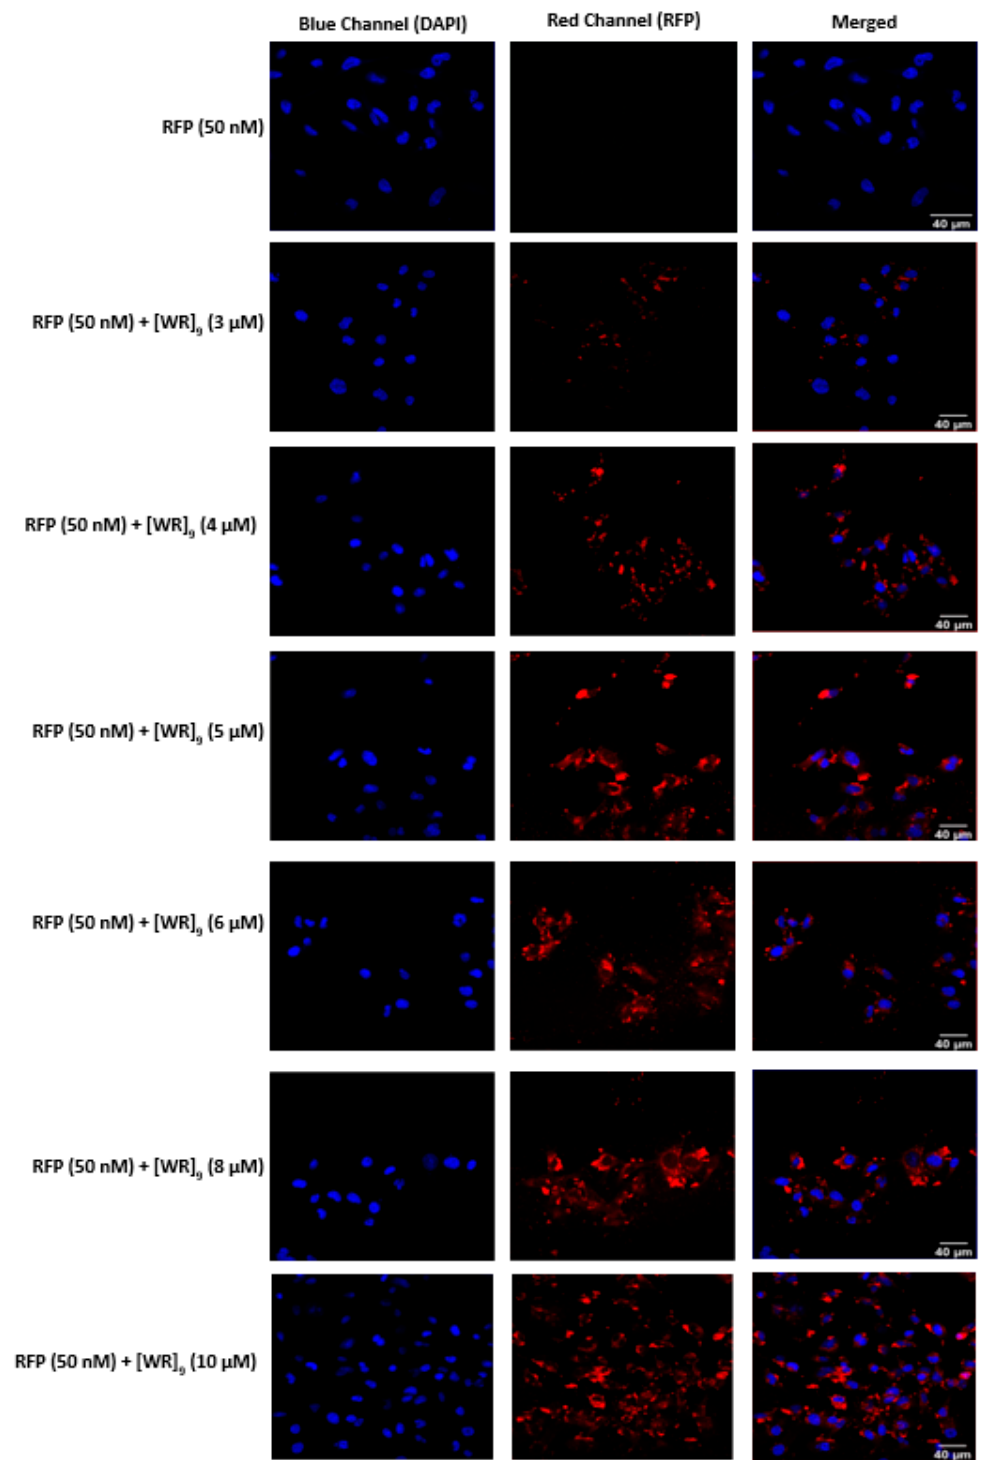
Figure 10. Confocal microscopy images of MDA-MB-231 cells incubated with the RFP-[WR] 9 mixture at a peptide concentration range (3–10 µ M) and RFP at (50 nM) for 3 h. The red and blue channels visualize RFP and DAPI (used to stain the nucleus), respectively.